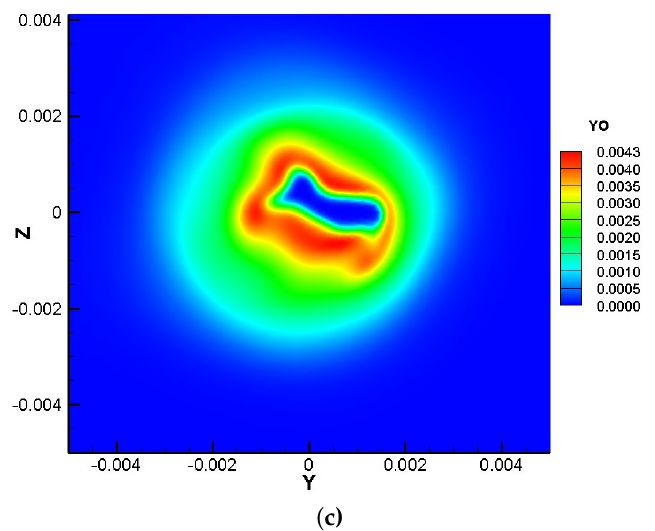
Figure 3. The transient field of case added ozone at 17.5 ms ( a ) The flame surface, temperature field, and O radicals field at c = 0.7; ( b ) the mass fraction of O radicals at cross-section x / D = 6; ( c ) the mass fraction of O radicals at cross-section x / D = 11.